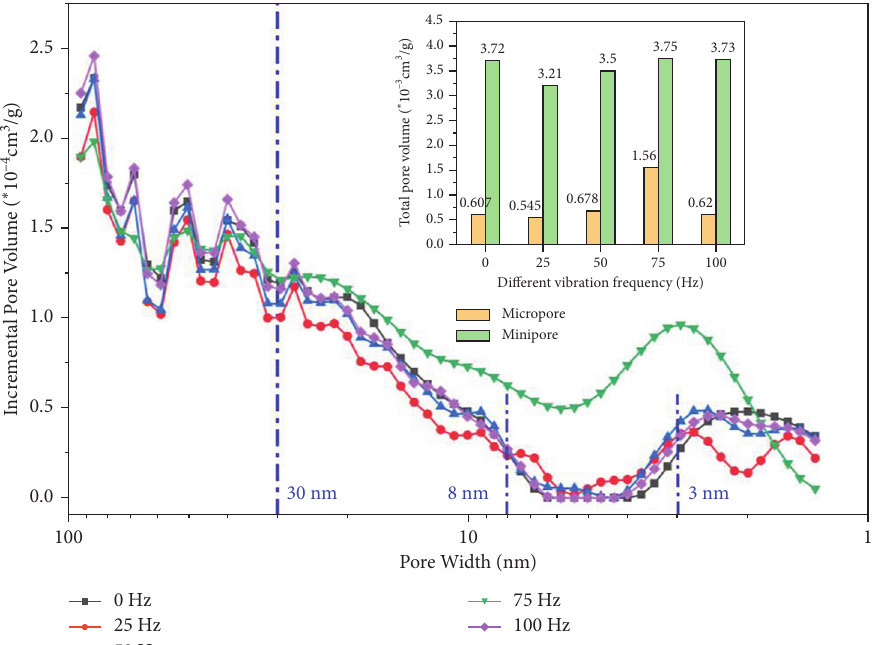
Figure 7: Pore size distribution of micropores and